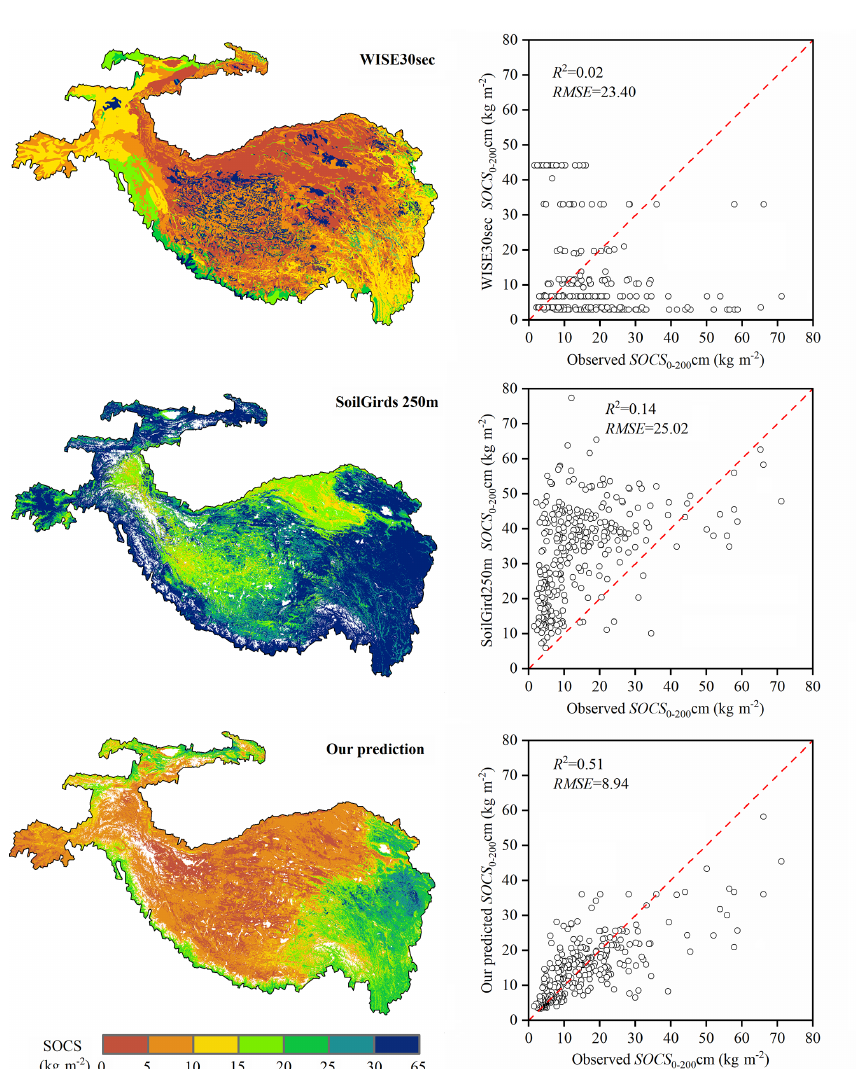
Figure 9. Comparison of the SOCS prediction with the WISE30sec from Batjes (2016) and the SoilGrids250m from Hengl et al. (2017) at 0–200cm depth intervals based on the 213 SOCS data from Ding et al. (2016) and field